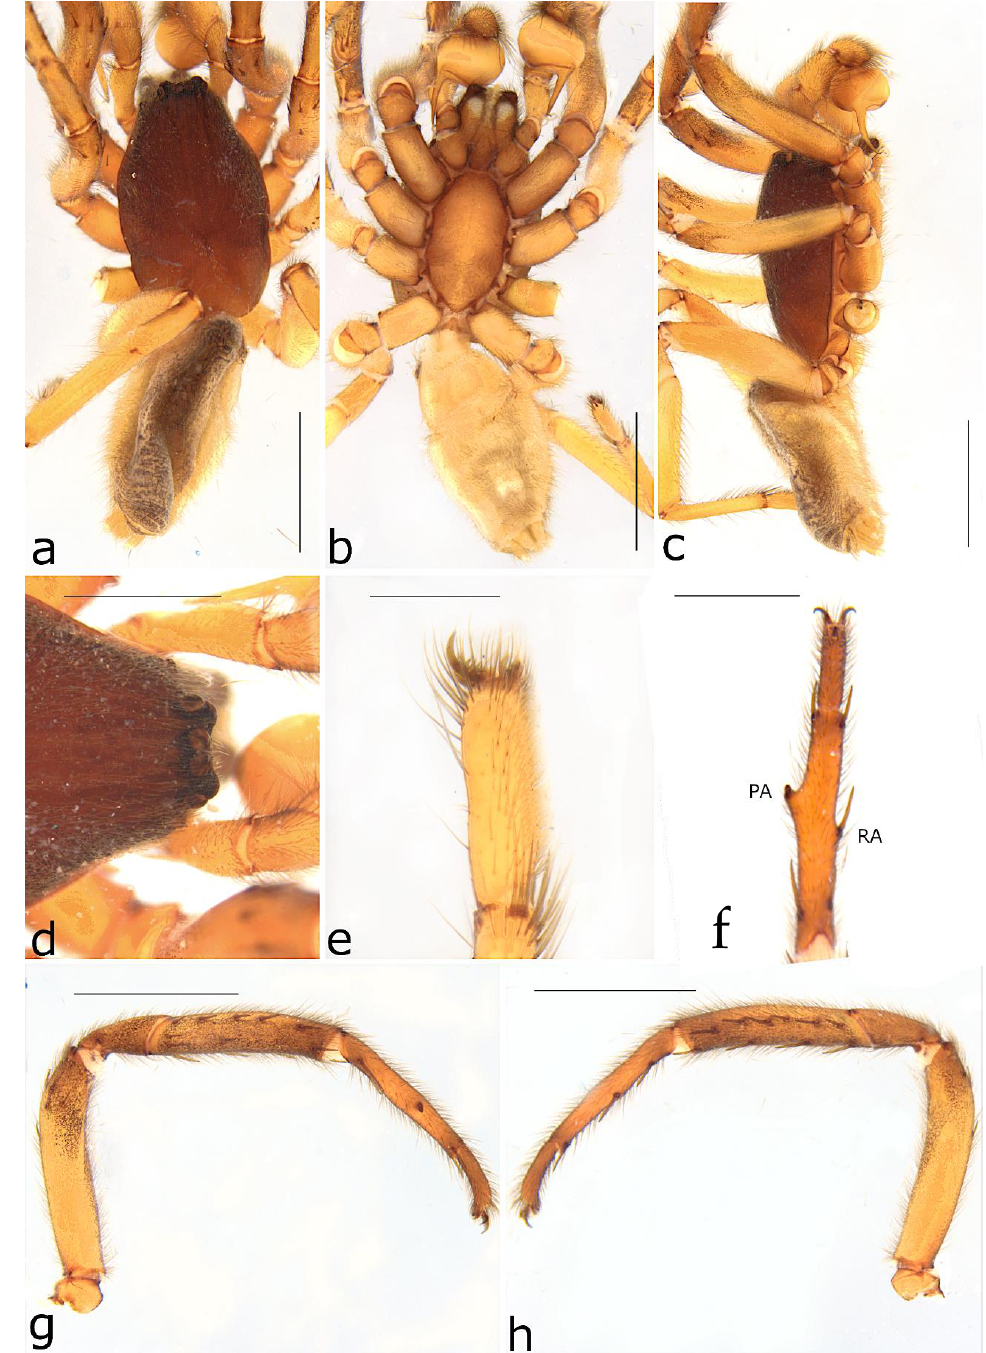
Figure 26. Ariadna arenacea sp. nov. ♂ holotype (SAMA NN30585) from North Wartaru (SA): ( a ) habitus, dorsal view; ( b ) same, ventral view; ( c ) same, lateral view; ( d ) eyes, dorsal view; ( e ) left metatarsus IV, preening comb, retrolateral view; ( f ) left leg I, ventral view; ( g ) same, prolateral view; ( h ) same, retrolateral view. Scale bars ( a – c ) = 2 mm, d, ( f ) = 1 mm, ( e ) = 0.5 mm and ( g , h ) = 2 mm.